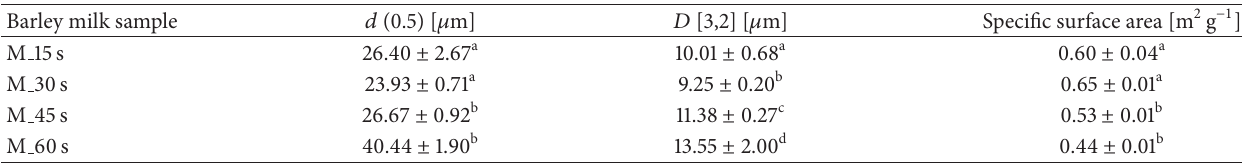
Table 1: Mean diameter ( 𝑑 (0.5)), Sauter diameter ( 𝐷 [3,2]), and specific surface area of barley based milk. Results are expressed as mean of 3 measurements ± SD ∗ .